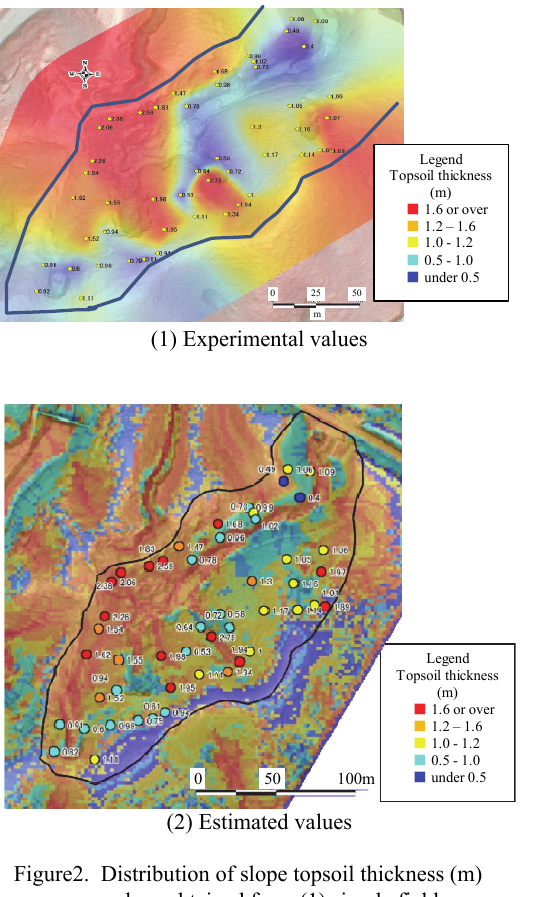
Figure2. Distribution of slope topsoil thickness (m) values obtained from (1) simple field cone penetration measurements and (2) model predictions